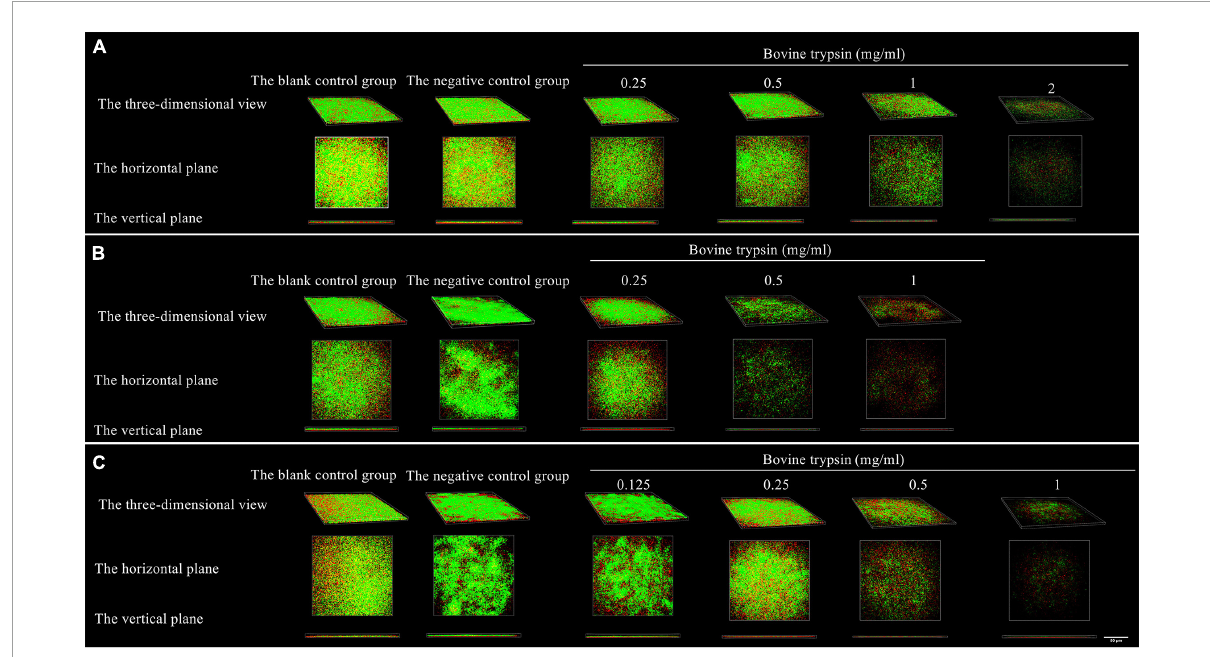
FIGURE5 The three-dimensional morphology observation of live and dead bacteria after 30 s, 1 min, and 3 min of bovine trypsin treatment by CLSM. (A–C) Are the form of live and dead bacteria in the biofilm after 30 s, 1 min, and 3 min of ovine trypsin treatment,